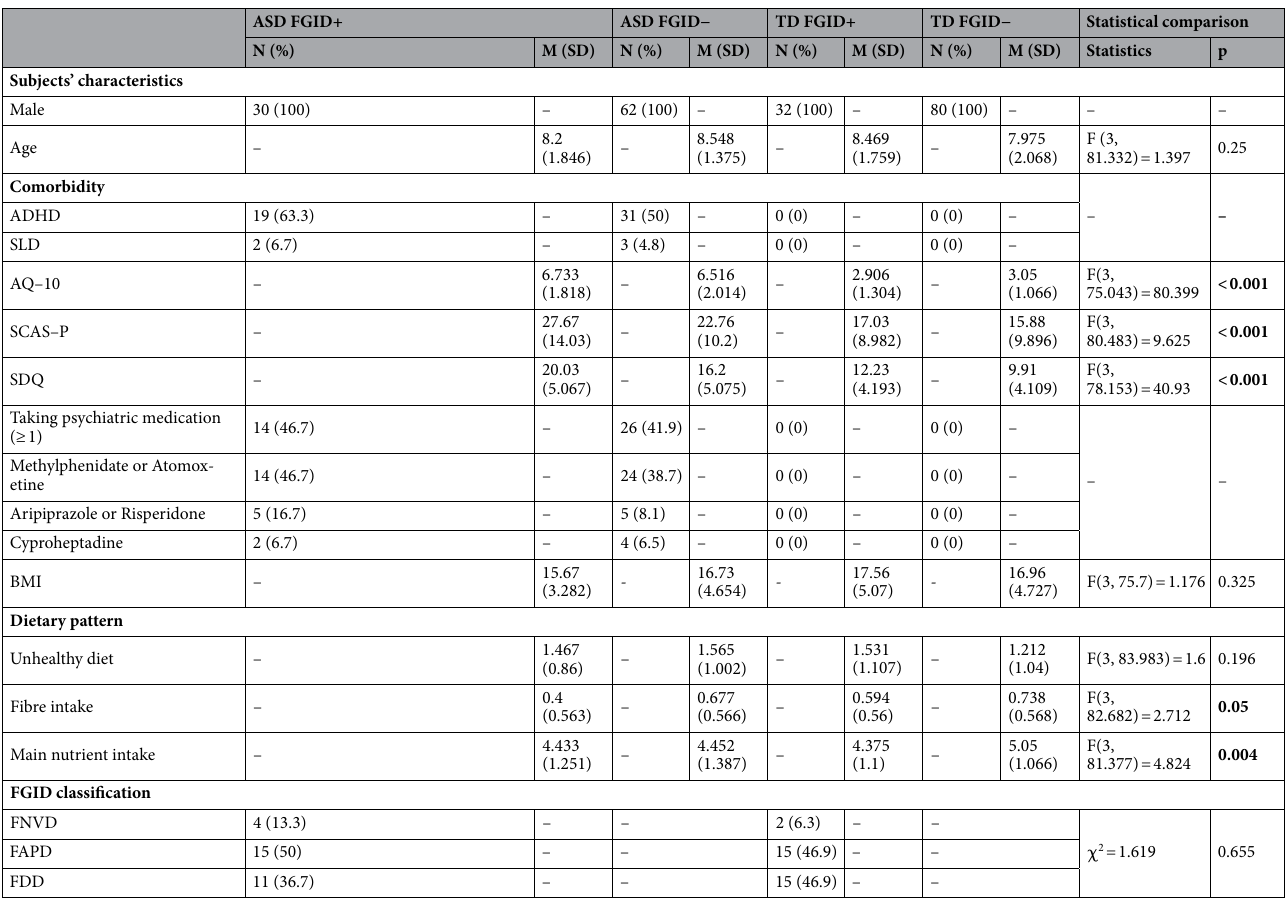
Table 1. Descriptive of subjects’ demographic, clinical characteristics, dietary patterns, and FGID classification. Significant values are in bold. ASD Autism Spectrum Disorder, TD Typically Developing,